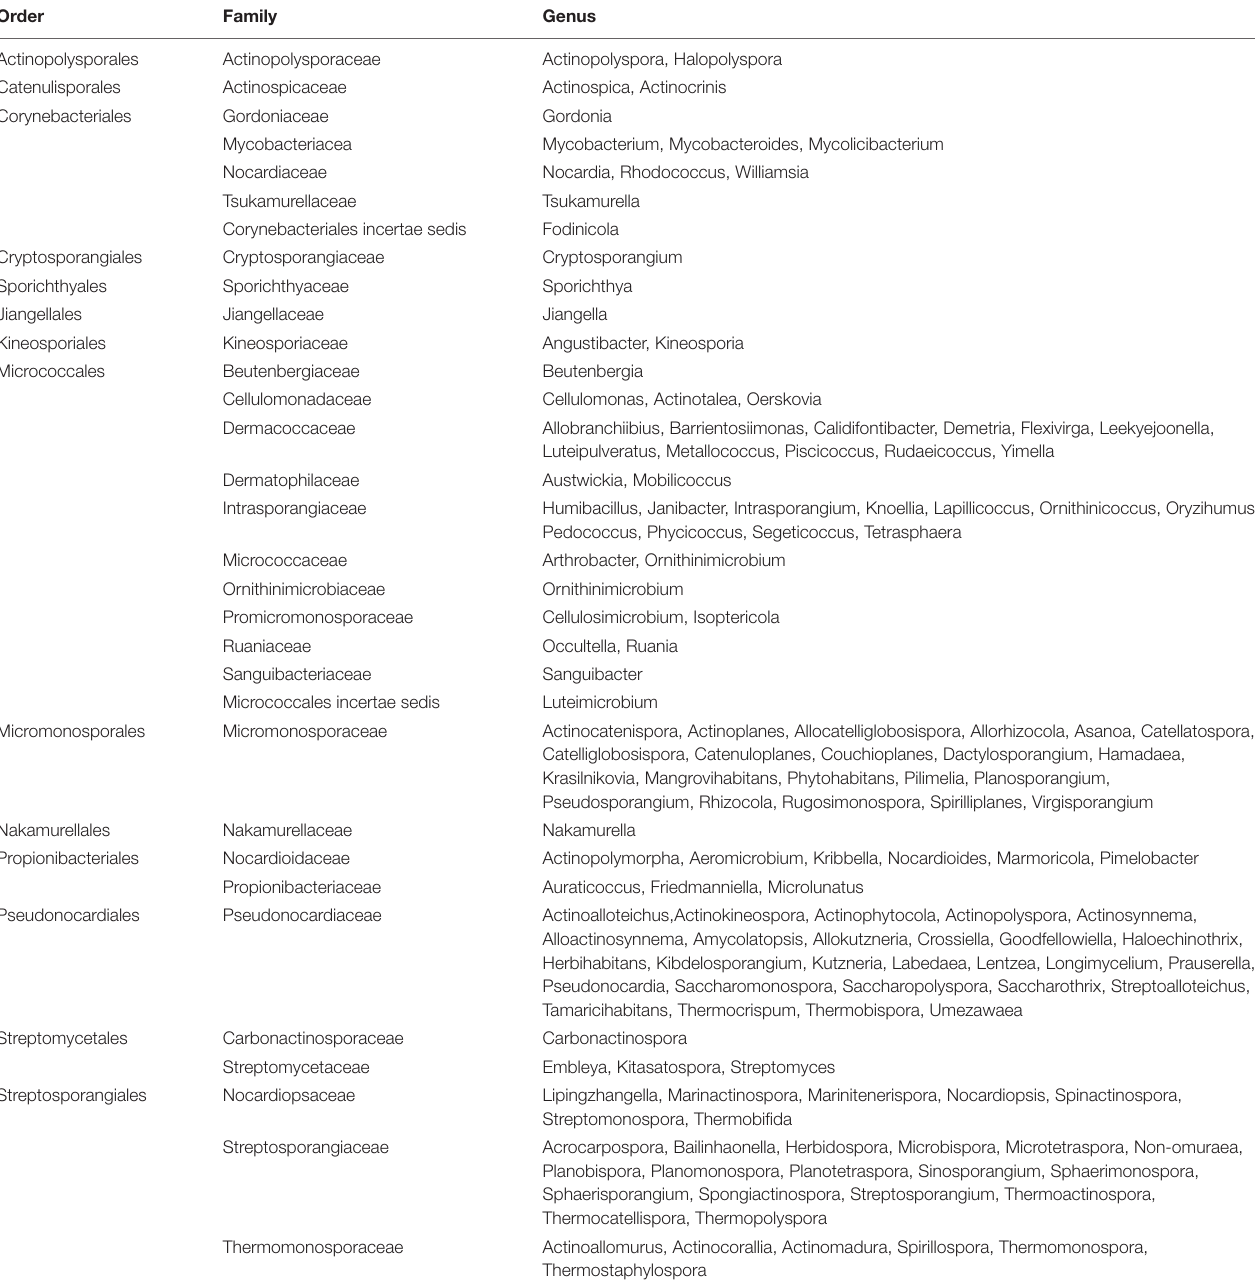
TABLE 4 | List of Actinobacteria orders, families, and genera with species with predicted Ms1 RNAs.